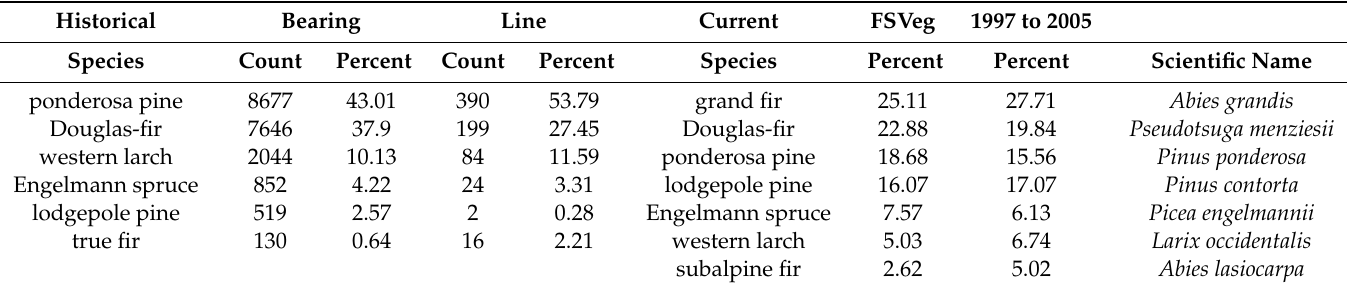
Table 1. Composition of historical bearing and line trees and current composition from Field Sampled Vegetation (FSVeg) imputation and 1997 to 2005 surveys for the Umatilla National Forest (if percent ≥ 2 for any survey).